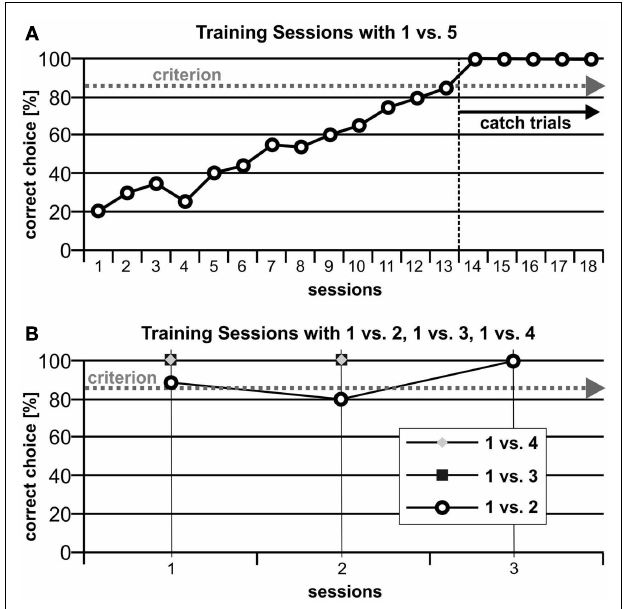
FIGURE 3 | (A) For the first stimulus pair 1:5, the subject needed 13 sessions to reach criterion. His performance remained stable even after the introduction of catch trials. (B) For the following numerosities, criterion was already reached in the first sessions.